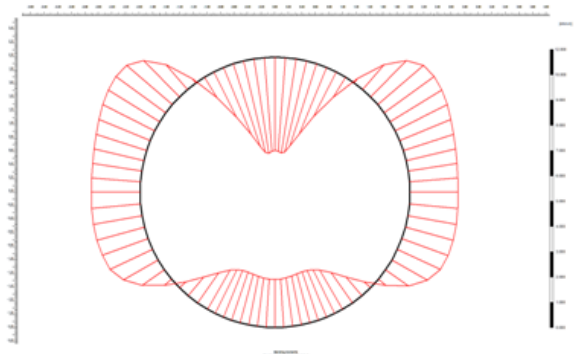
Figure 11. Bending moment diagram for fibre rein- forced sand backfill ( M max = 3 . 78 kNm)